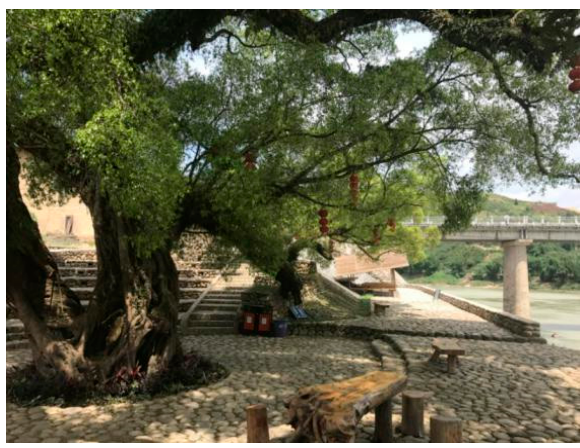
Figure 3. The Banyan Square.